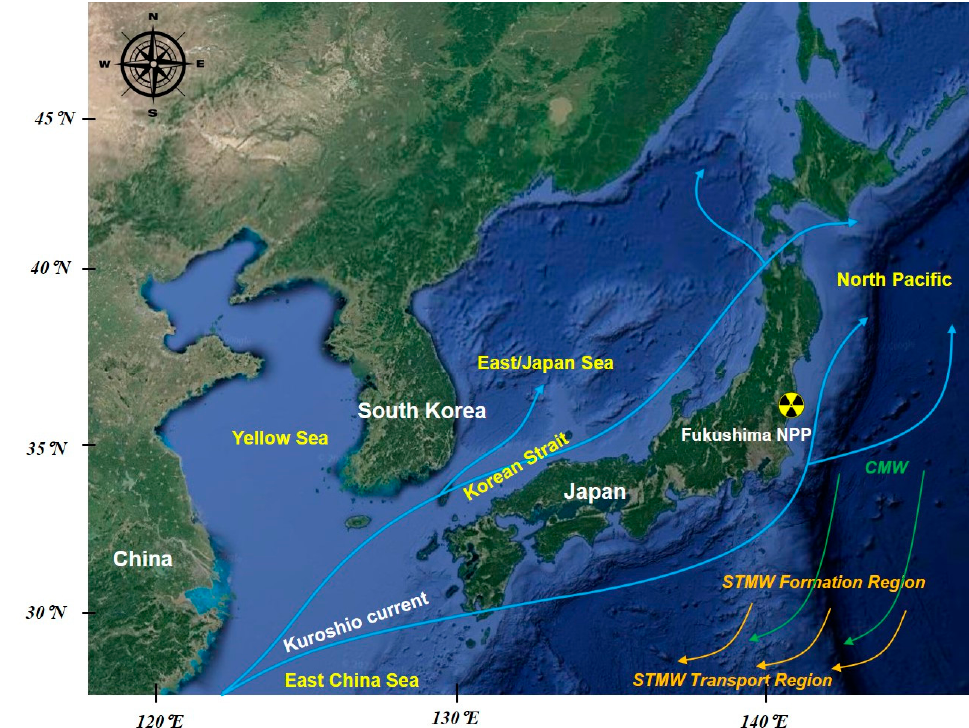
Figure 1. Map showing the locations of the Korean seas (East/Japan Sea and Yellow Sea), the Korean Strait, and the Asian countries in the marginal region of the North Pacific with the major current